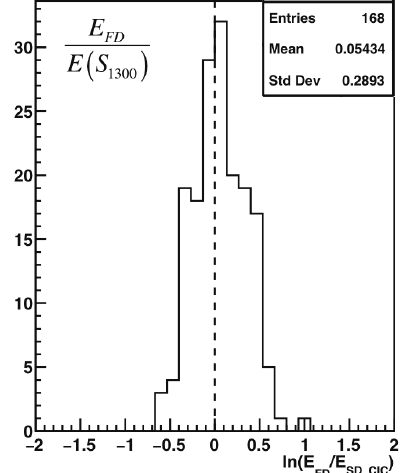
Figure 10. Ratio of the SD to FD energies for the TA hybrid events above 10 19 eV. The SD energy is estimated from S